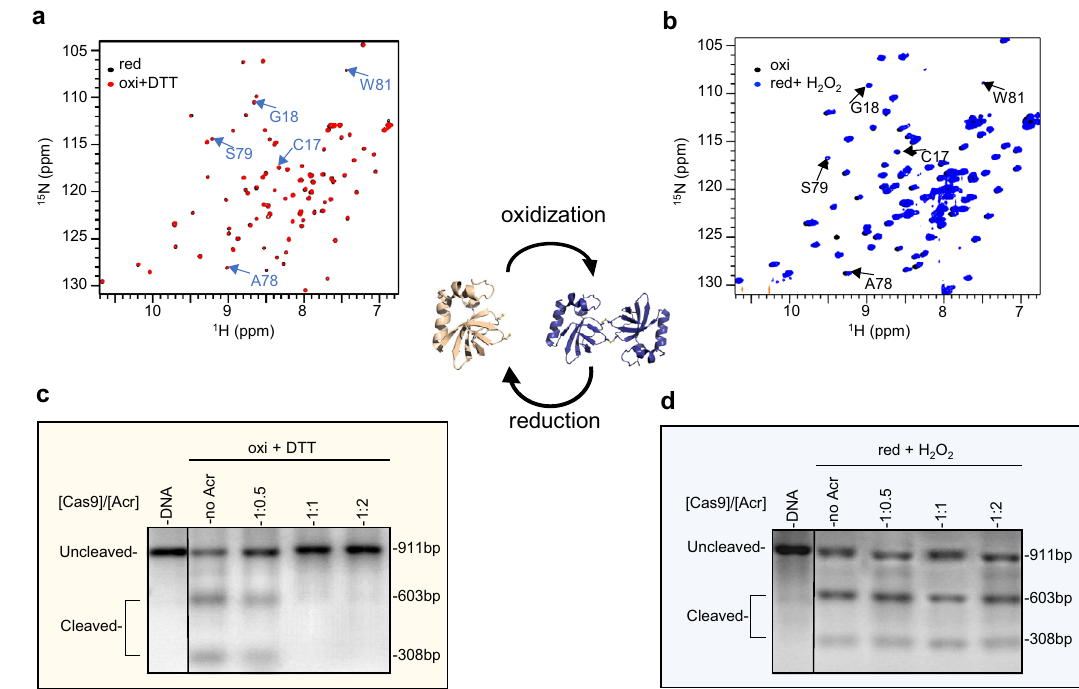
Fig.4|Thetworedoxstatesof Nme AcrIIC1canbeinterconvertedandmediated by the pair of Cys17-Cys80. a Superimposition of 1 H- 15 N HSQC spectra of the reduced Nme AcrIIC1 (black) and that after recycling from the oxidized state (red). To better demonstrate the change of the structure from 1 H- 15 N HSQC, peaks with signi fi cant CSD between the two states of Nme AcrIIC1 are indicated with blue arrowsandlabeled. b Superimpositionof 1 H- 15 NHSQCsoftheoxidized Nme AcrIIC1